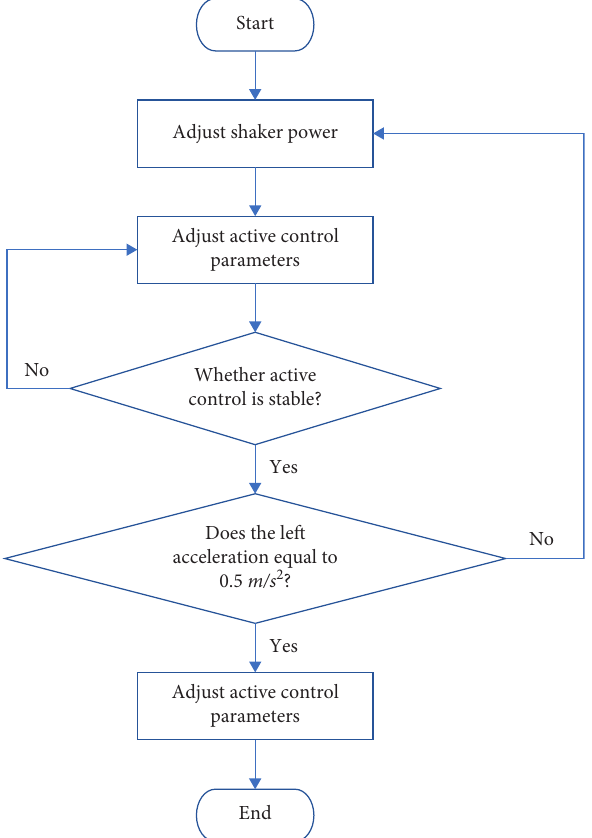
Figure 27: Experiment process.